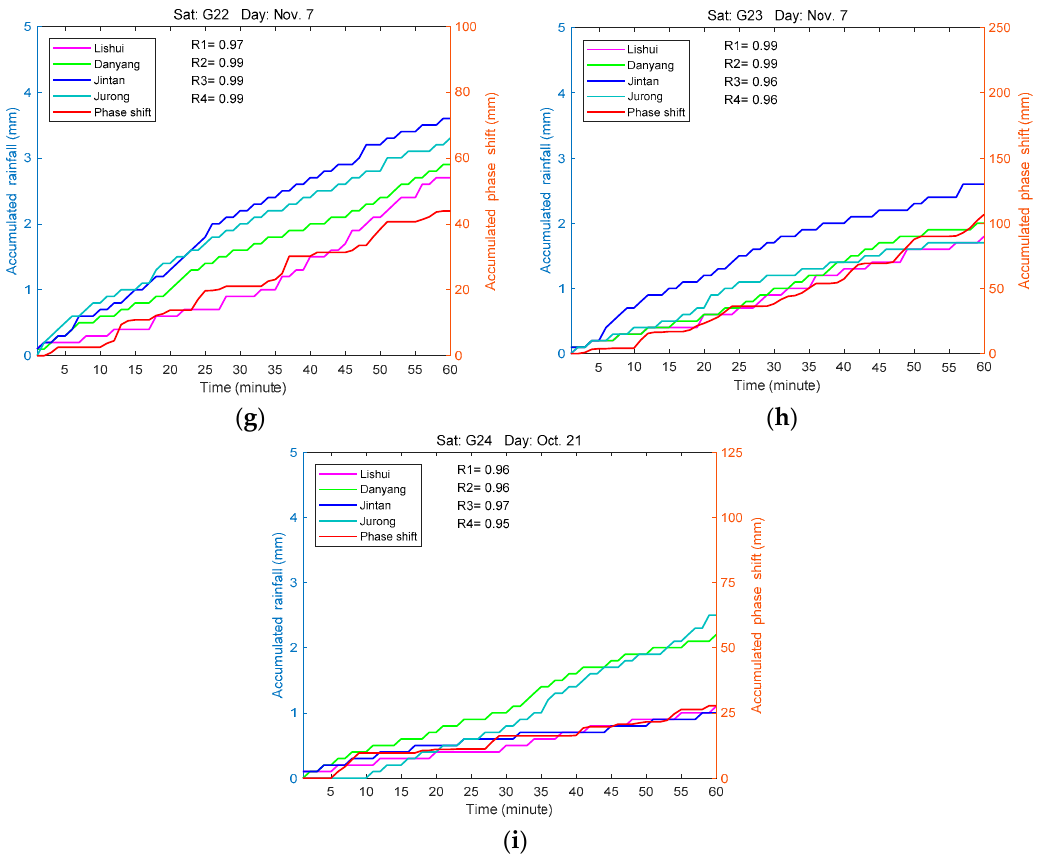
Figure 15. Cases of accumulated phase shift from different GPS satellites compared with accumulated rainfall observed from four nearby weather stations: ( a ) G1 in Oct. 2; ( b ) G3 in Sep. 15; ( c ) G3 in Nov. 7; ( d ) G9 in Nov. 7; ( e ) G11 in Oct. 2; ( f ) G13 in Oct. 21; ( g ) G22 in Nov. 7; ( h ) G23 in Nov. 7; ( i ) G24 in Oct. 21.